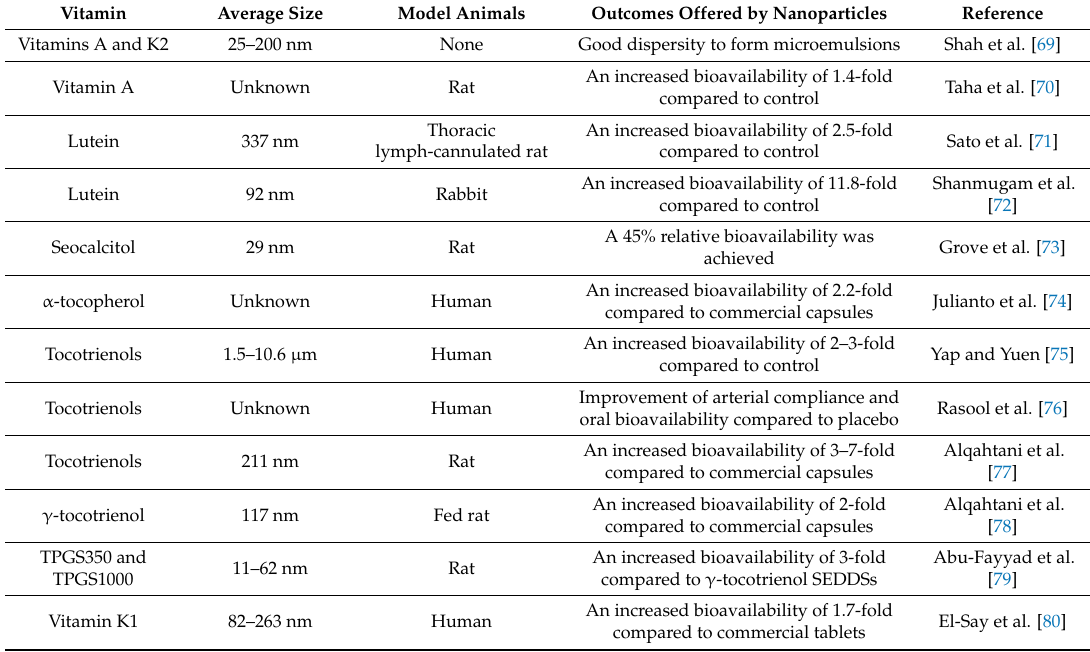
Table 1. Characterization of self-emulsifying drug delivery systems (SEDDSs) loaded with vitamins or their derivatives and their oral